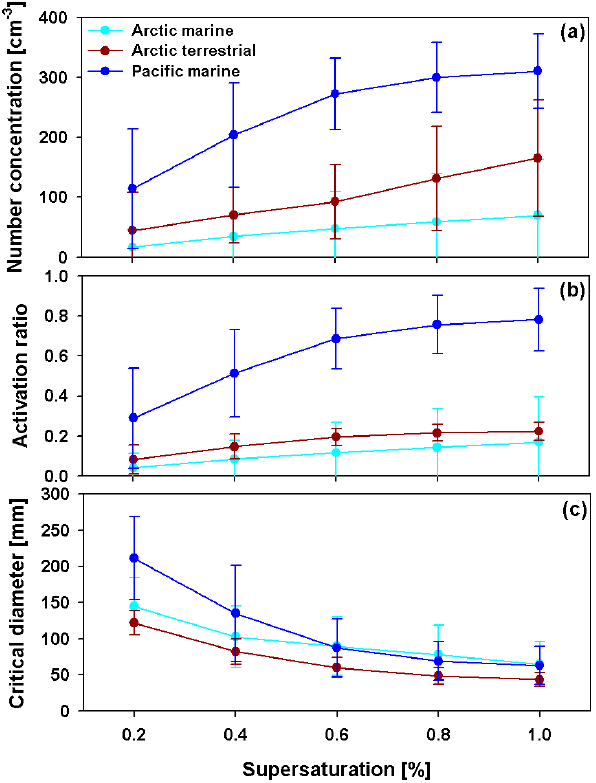
Figure 10. Comparisons of (a) CCN number concentrations; (b) CCN activity; and (c) critical diameter for Arctic marine, Arctic terrestrial and Pacific marine air masses under different supersatu- ration conditions. The error bars represent a standard